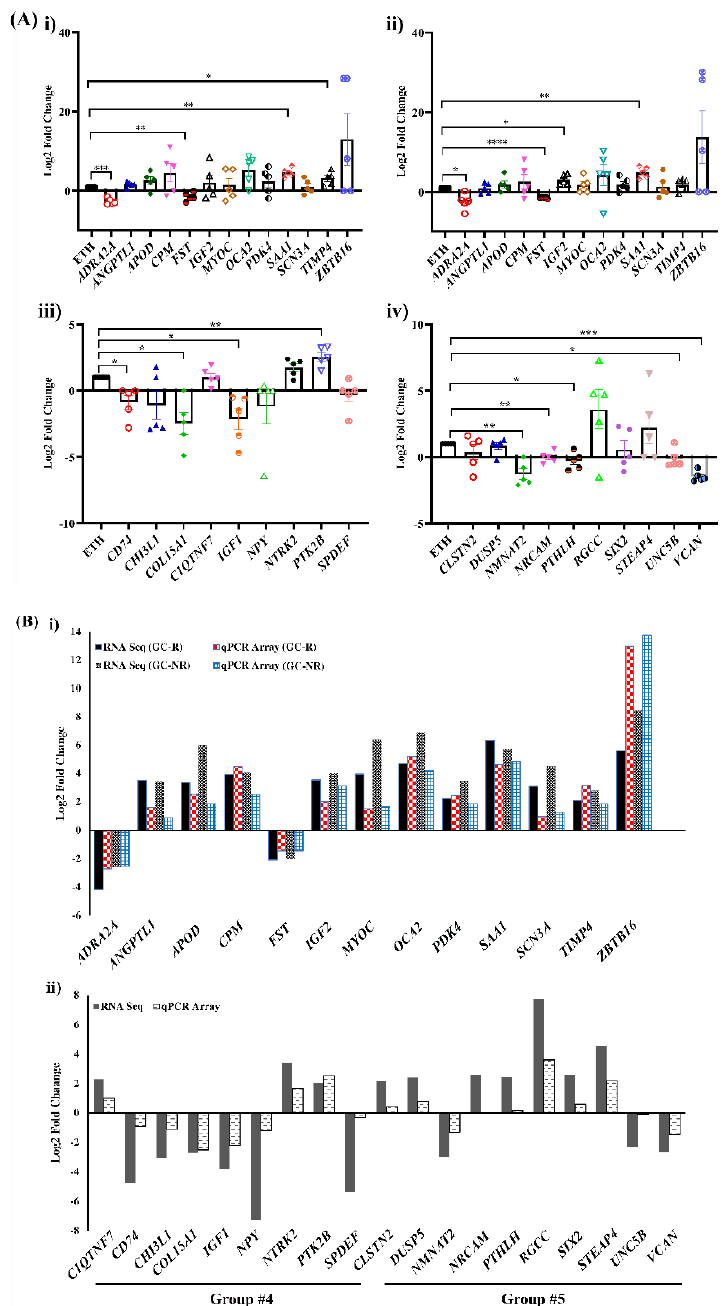
Figure 4. ( A ) Validation of DEGs by RT 2 -PCR Array. Expression profile of selected genes identified from RNA-seq and validated by RT 2 -Profiler PCR array is shown. Primary HTM cells were treated with 100 nM DEX or 0.1% ETH for 7 days. Total RNA was extracted, converted to cDNA, and the expression profile of selected genes were carried out by RT 2 -PCR array as per the manu-acturer’s instructions (refer to the methods). Gene expressions were normalized to ACTB and ana-lyzed using the 2 −ΔΔ CT method followed by Log 2 FC calculation. (i) Expression profile of selected genes from Group #3-GC-R, (ii) Group #3-GC-NR, (iii) Group #4, and (iv) Group #5 are shown. The data are represented as mean ± SEM. * p <0.05; ** p <0.01; *** p <0.001, **** p <0.0001. Paired 2-tailed Student’s t test. ( B ) Validation of RNA sequencing findings by RT 2 -PCR Array. Out of 32 genes, the expression pattern identified from RNA-seq of 30 genes matched with RT 2 -PCR array analysis. DEGs from (i) Group #3, (ii) Group #4, and Group #5.